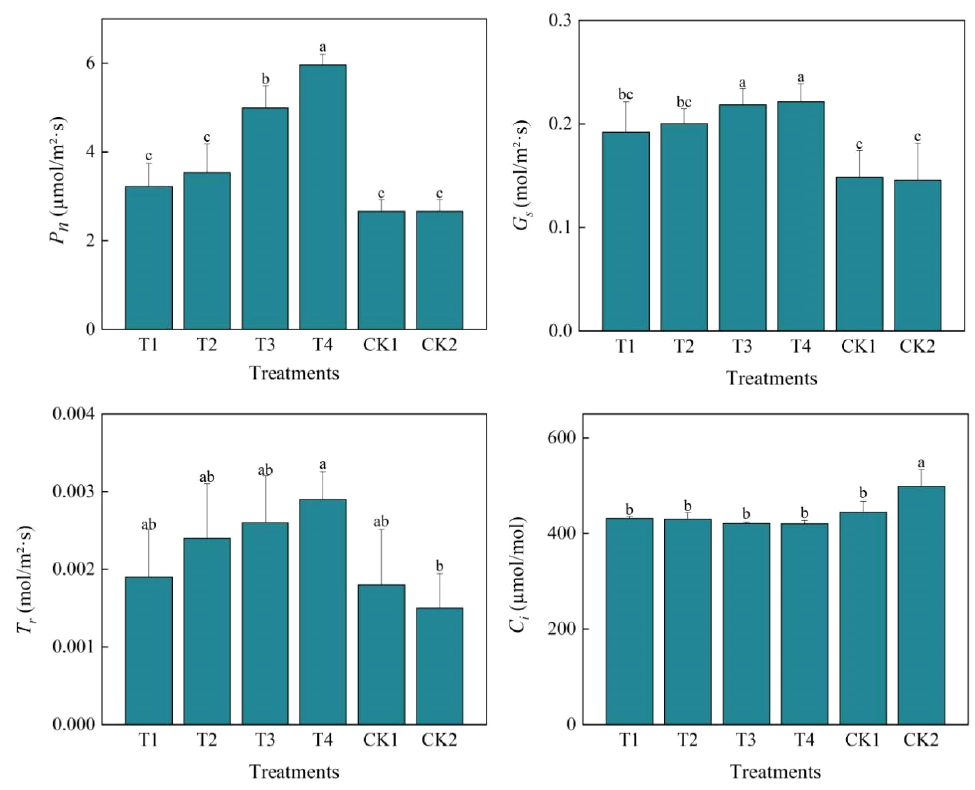
Figure 6. Effect of different heating treatments on photosynthetic parameters of cucumber leaves. Note: different lowercase leters in the same column in the figure indicate that the difference between different treatments reaches asignificant level of p < 0.05.